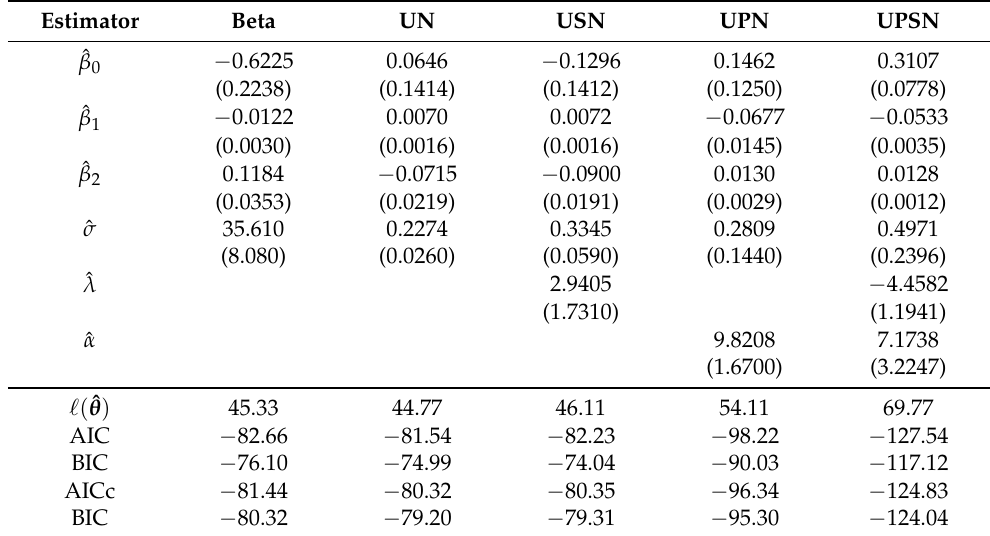
Table 6. Estimations of the parameters, with their standard errors, of the regression models beta, UN, USN, UPN and